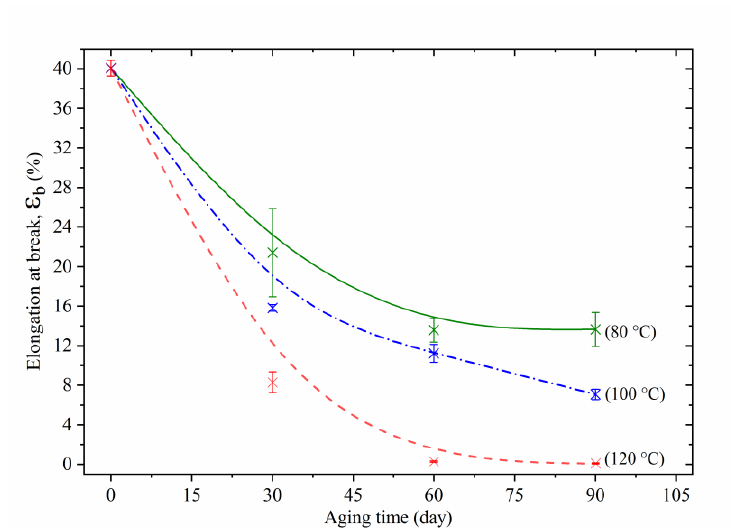
Fig. 4. Variation of the elongation at break of (u-PVC) aged at (80, 100 and 120 °C) versus aging